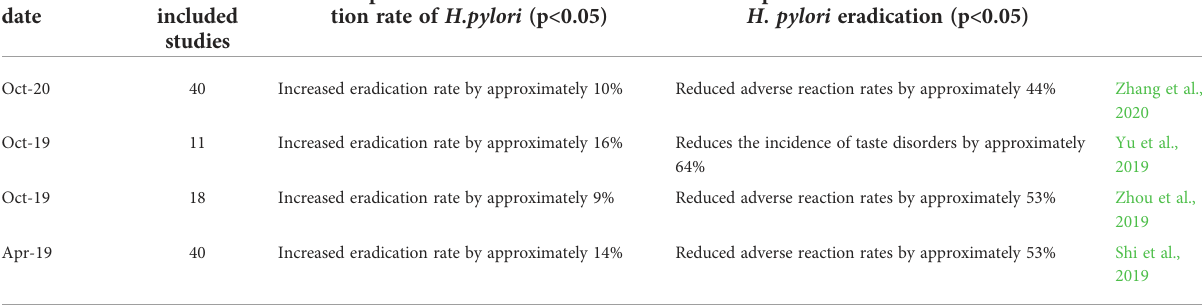
TABLE 3 Main results of meta-analysis of the effect of probiotic supplementation on H. pylori eradication published in 2019-2020.